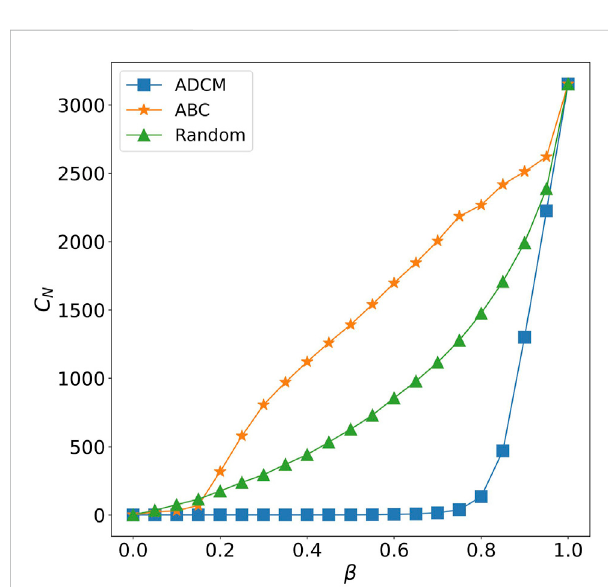
FIGURE 4 The effect of edge removing on network connectivity based on different methods. We show the number of connected components ( C N ), as a function of the faction of removed edges ( β ) in the Global airline network. We compare three different approaches: ADCM, ABC and